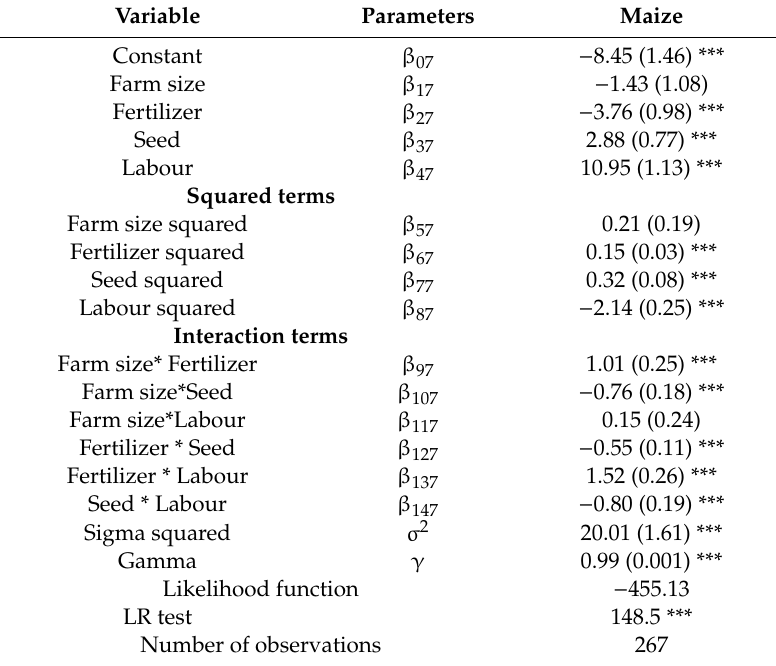
Table 3. Estimates of stochastic frontier trans-log production function for maize. Variable Parameters